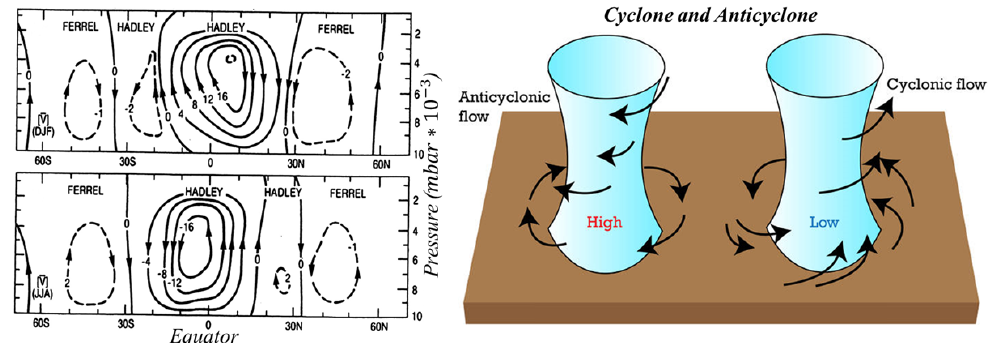
Figure 9. Mean meridional circulation of the atmosphere and